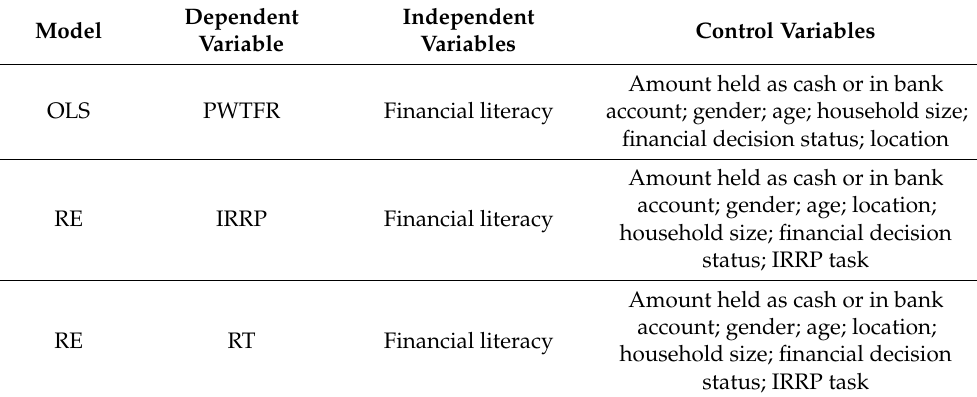
Table 2. Regression model